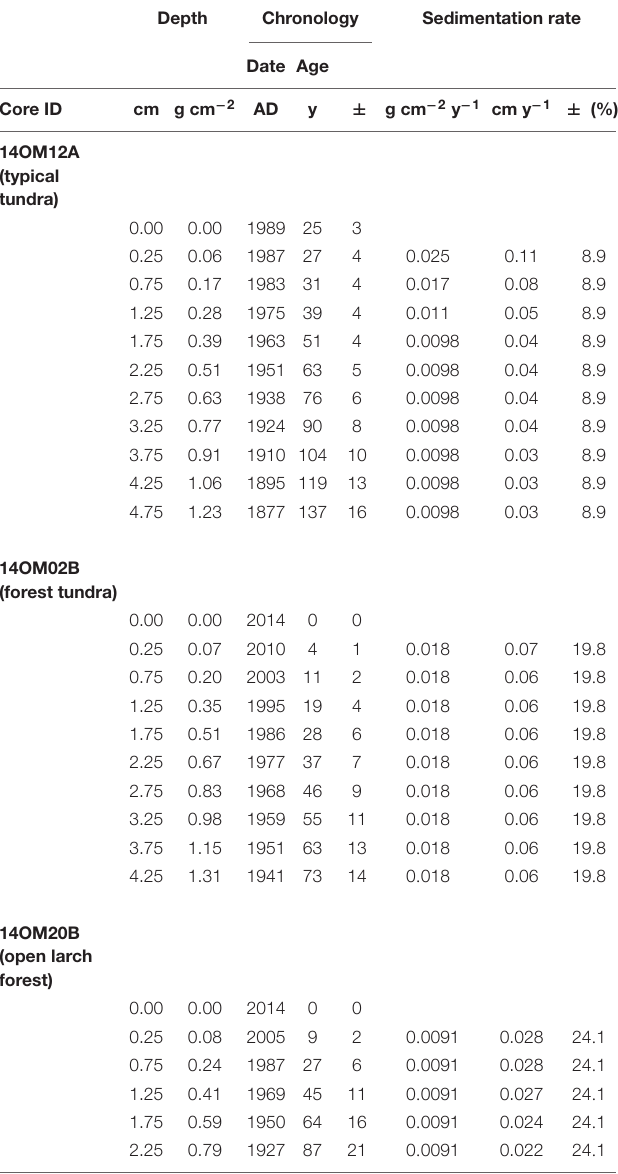
TABLE 1 | 210 Pb/ 137 Cs dating results for Omoloy cores 14OM12A, 14OM02B and 14OM20B, northern Siberia.